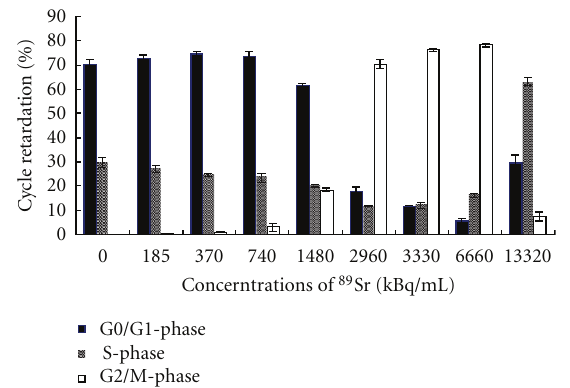
Figure 6: The mitochondrion ΔΨ m of MCF-7 cell apoptosis due to being induced by 89 Sr of various radioactive concentrations.